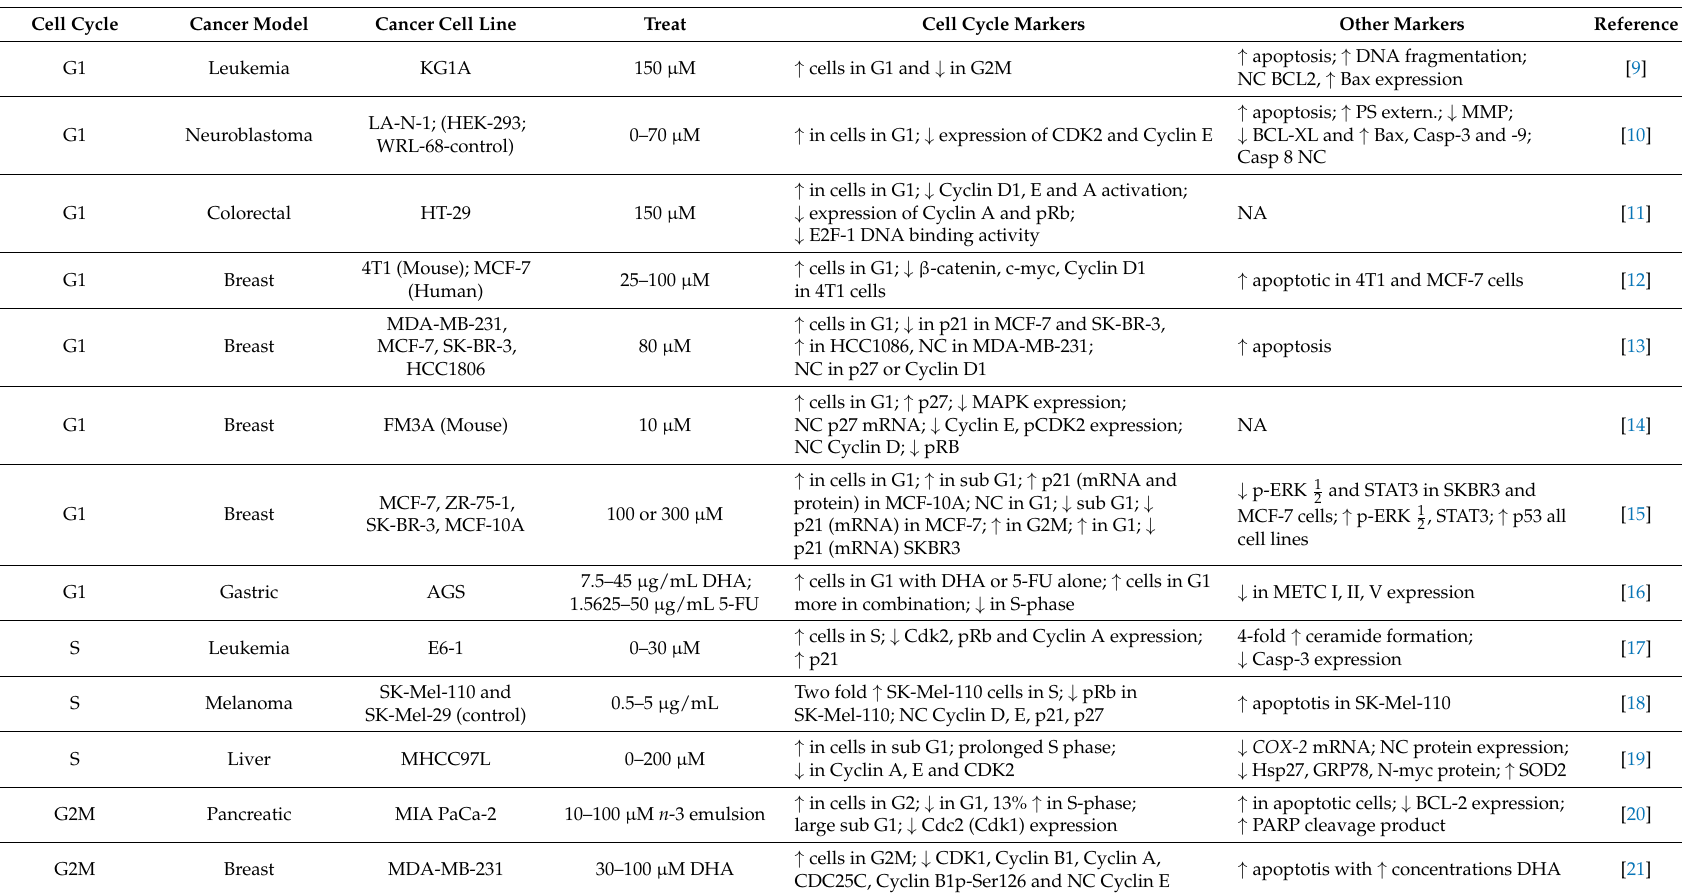
Table 1. Overview of in vitro studies investigating cell cycle in cancer cells treated with docosahexaenoic